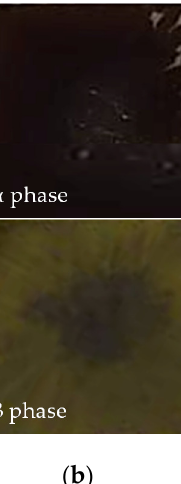
Figure 2. ( a ) Colloidal solutions at different synthesis temperatures in toluene under UV lamp ( λ = 365 nm). ( b ) CsPbI 3 -QD (0 hour) at different synthesis temperatures.